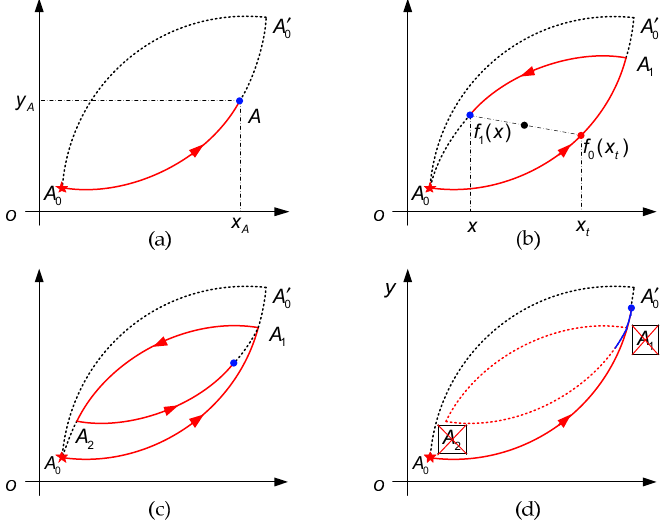
Figure 1. Schematic illustration of Madelung’s rules. ( a ) Trajectory on the major ascending curve A 0 A (cid:48) ; ( b ) Trajectory on A 1 A 0 ; ( c ) Trajectory on A 2 A 1 ; ( d ) Transfer of the trajectory from A 2 A 1 to A 0 A (cid:48) 0